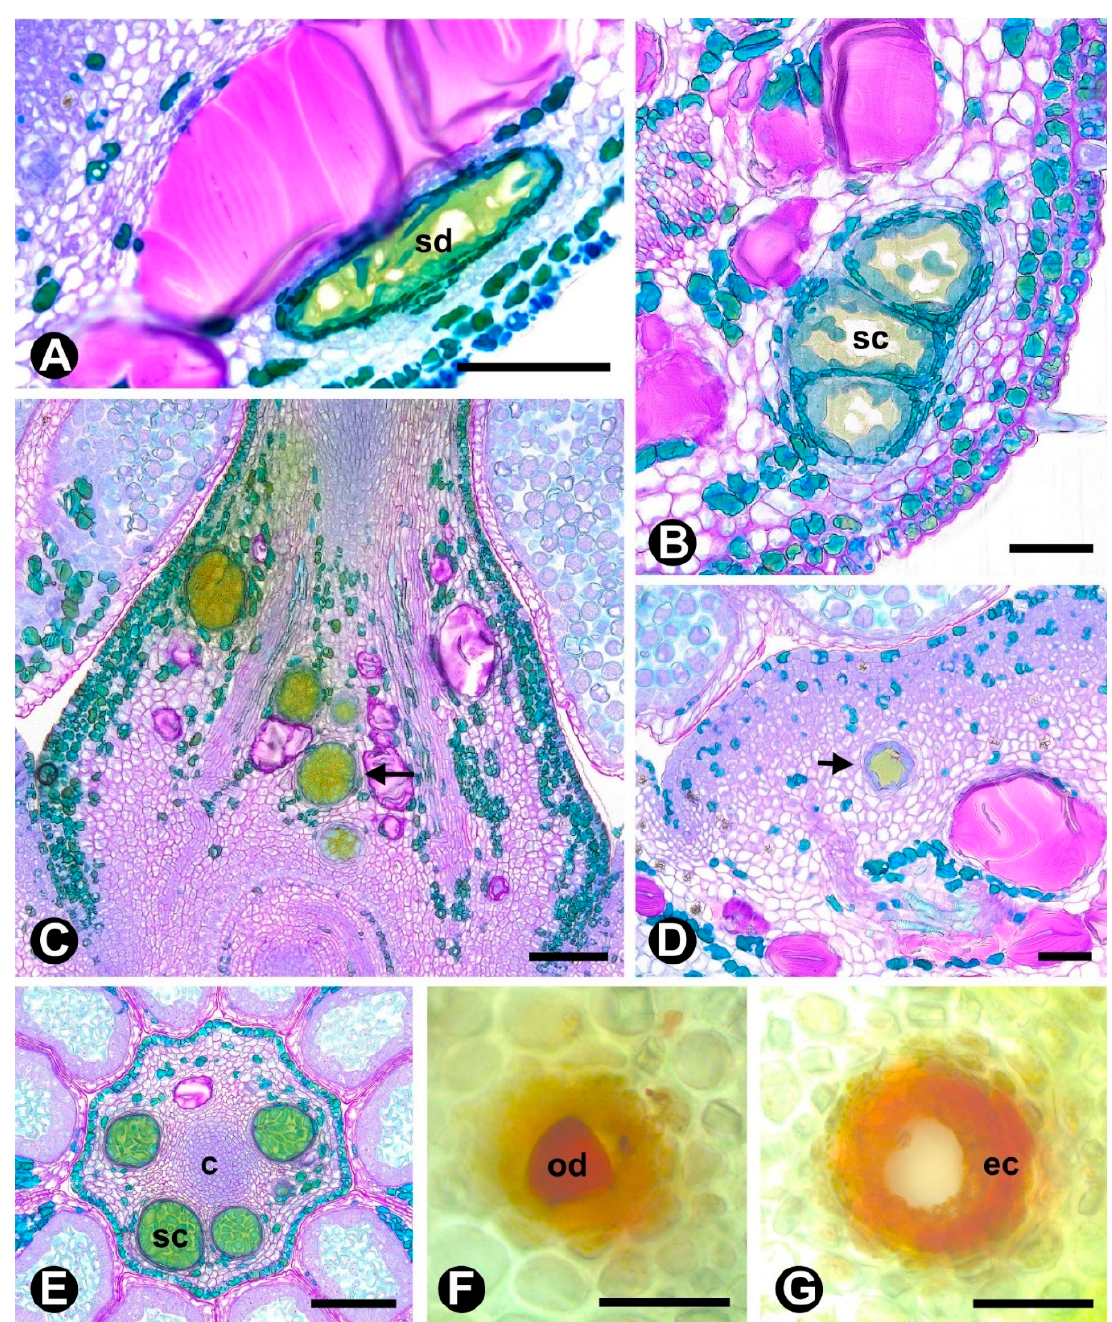
Figure 5. Secretory cavities and ducts in the flower of Rhamnidium elaeocarpum . ( A , C , D ) are longitudinal sections; ( B , E ) are transverse sections; and ( F – G ) free-hand sections. ( A – E ) = Toluidine Blue, ( F – G ) = Sudan III. ( A – E ) Secretory cavities and ducts (arrows) in the hypanthium ( A , B ), ovary ( C , E ), and below the nectariferous parenchyma ( D ). ( F – G ) Positive result for Sudan III revealing the lipids inside the lumen and secretory epithelial cells. Symbols: c = gynoecial compitum, ec = epidermal cells, od = oil drop, sc = secretory cavity, sd = secretory duct. Scale bars: ( A , C , E ), 100 μ m; ( B , D , F , G ), 50 μ m.